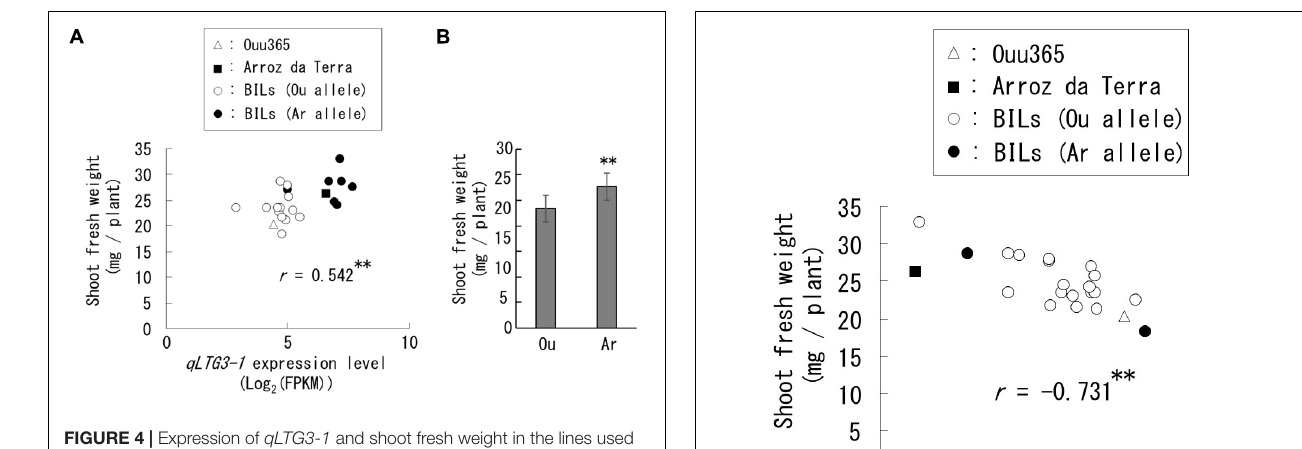
FIGURE 4 | Expression of qLTG3-1 and shoot fresh weight in the lines used for RNA sequencing. Each symbol indicates the parental cultivars and BILs that have the Ouu365 (Ou) or Arroz da Terra (Ar) allele for qLTG3-1. (A) Relationships between qLTG3-1 expression and shoot fresh weight. The r -value indicates the correlation coefficient. ∗∗ P = 0.0092 ( n = 22). (B) Mean value of the shoot fresh weight in each allele for qLTG3-1 with standard deviations. ∗∗ P = 0.0026 (Ou: n = 14, Ar: n = 8).